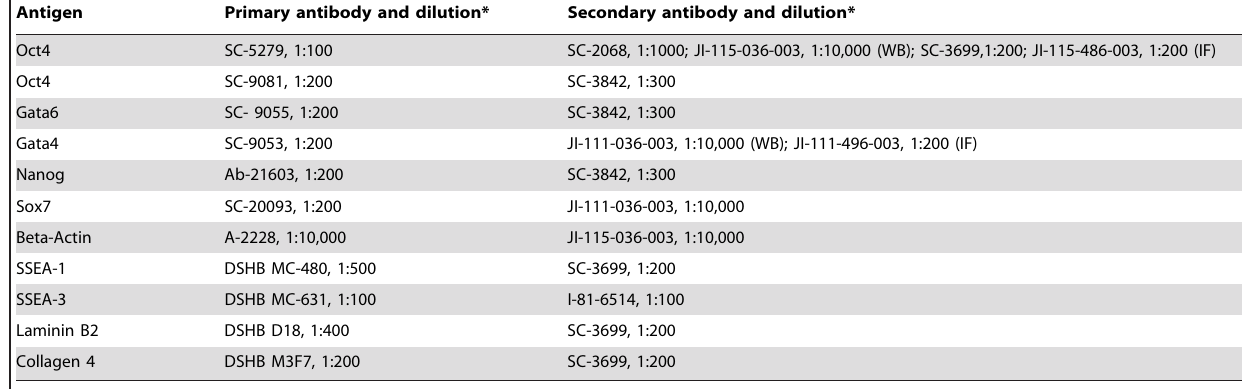
Table 4. List of antibodies used in this study.